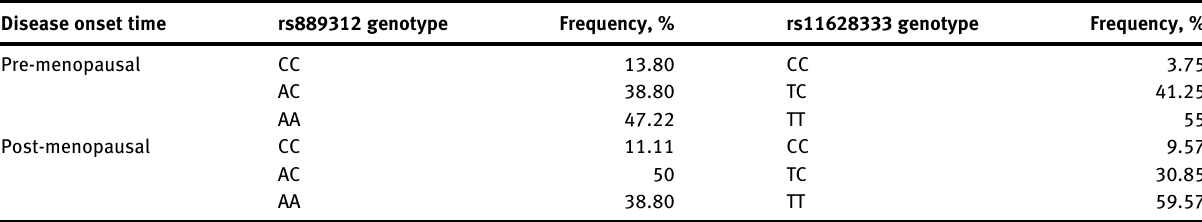
Table  : Genotype frequency of pre and post-menopausal breast cancer patients for rs  and rs  SNPs. Disease onset